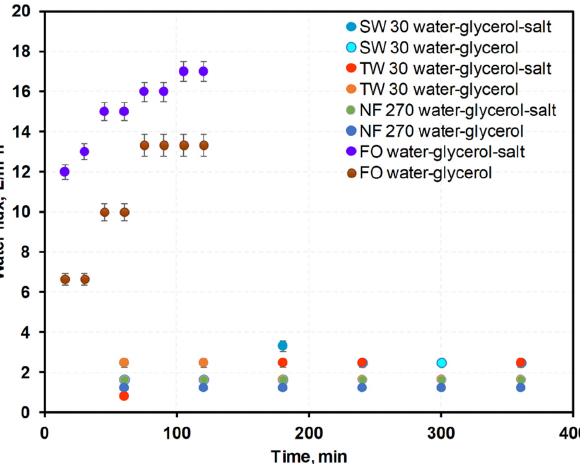
Figure 3. Measured water fluxes through membranes for water–glycerol and water–40% glycerol–3% NaCl solutions.